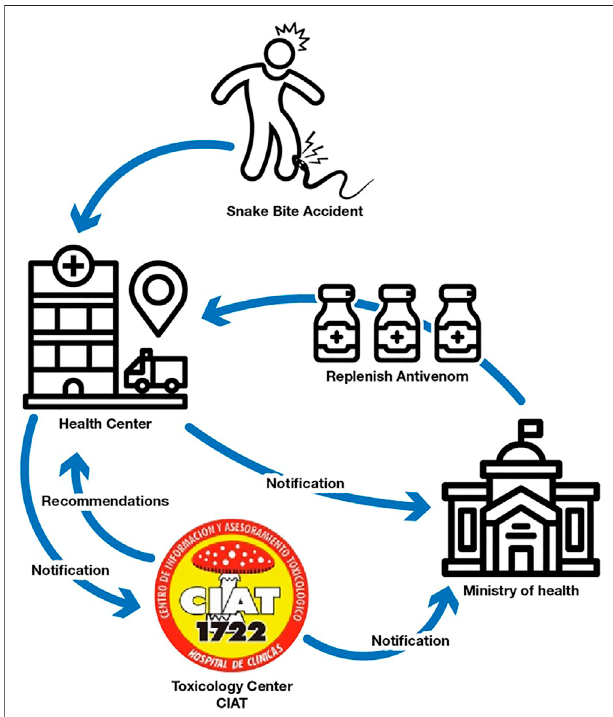
FIGURE 1 | Flowchart of noti fi cation steps in a snake bite accident.